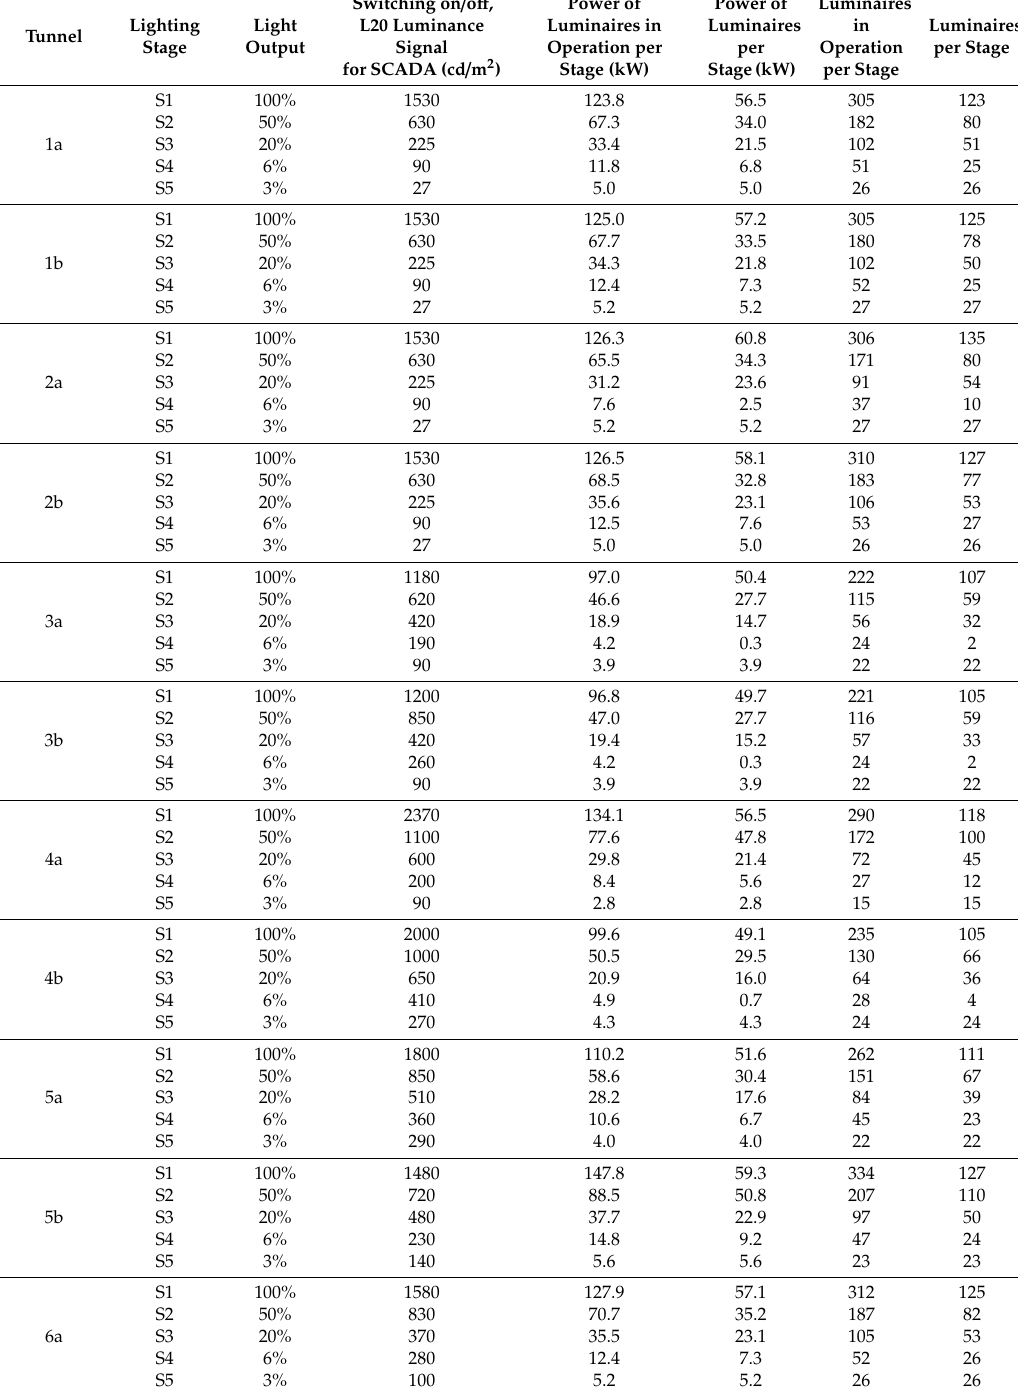
Table 7. Extracted L20 values from Supervisory Control and Data Acquisition (SCADA) system for Scenario A (switching control with existing Lth values) along with the number of luminaires grouped per lighting stage and the corresponding installed power for all the examined